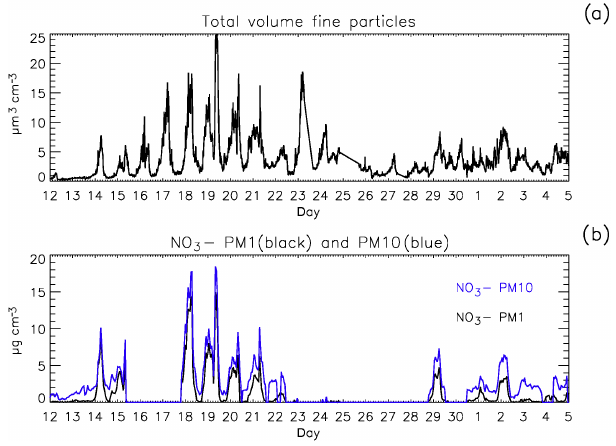
Figure 12. APSS fine-particle ( D p < 1µm) volume contribution (a) compared to nitrate ion concentration (NO − (black) and PM 10 (blue) channel (b) . Zero values correspond to missing